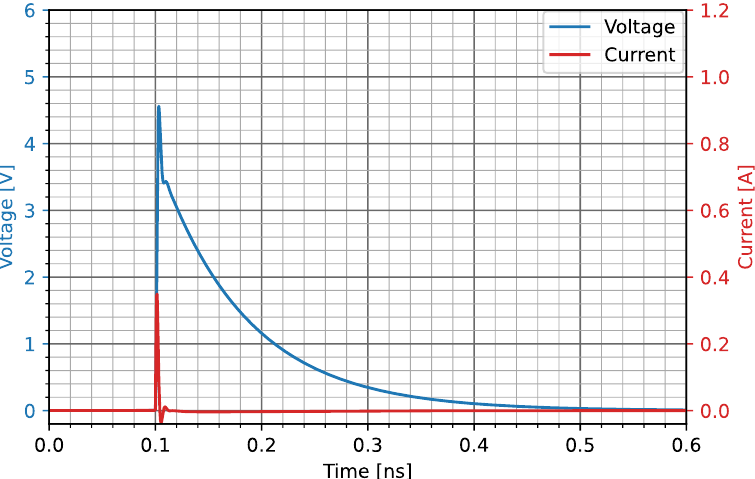
Figure 39. Simulated voltage and current curves (large-signal transient stimulus, applied in the re- verse